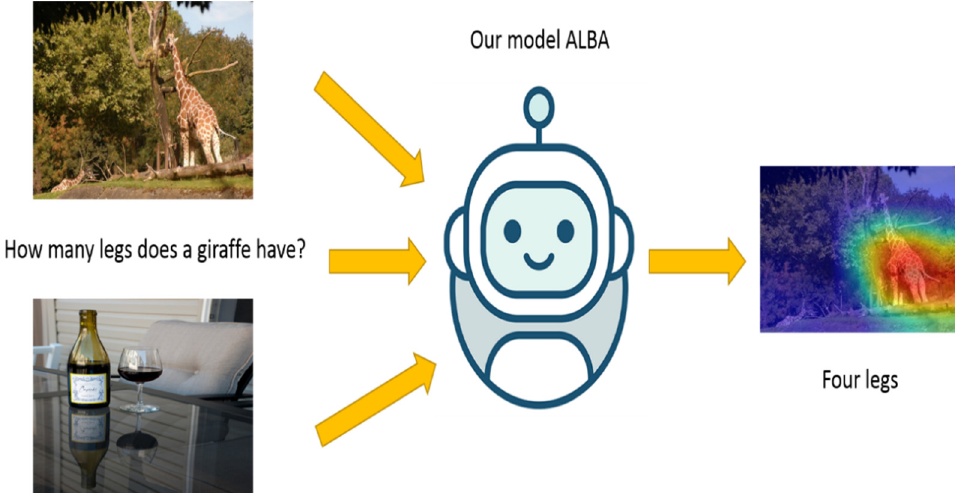
Figure 1. As an example, our model fuses features of the target image and the adversarial image according to the question, predicts the correct answer, and visualizes the